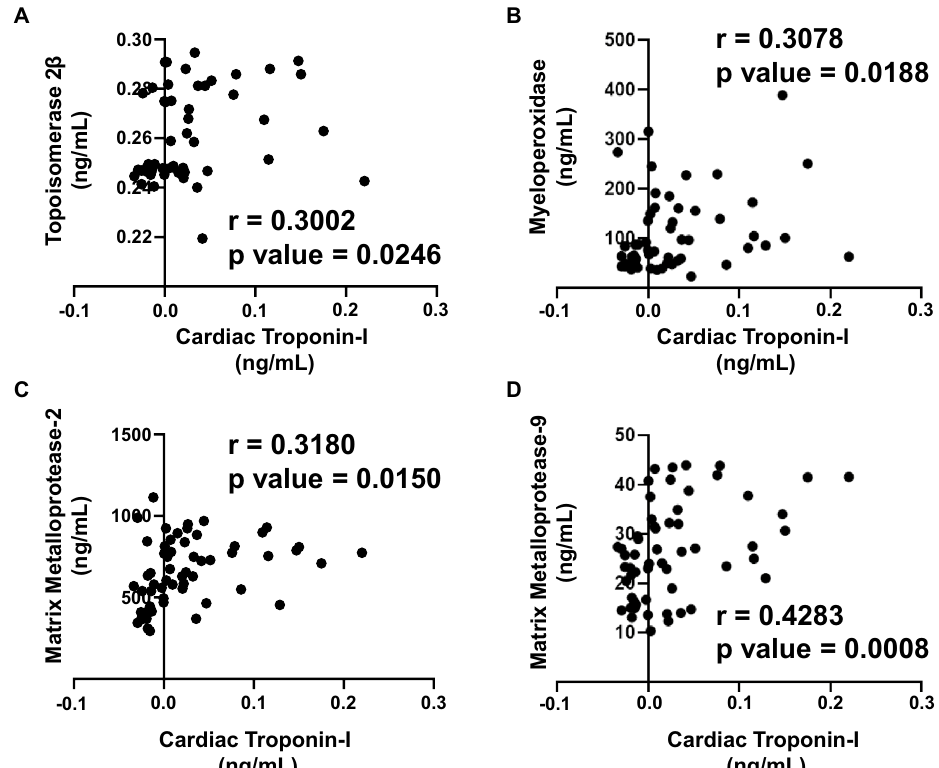
Figure 3. Correlation analysis of plasma biomarkers with high sensitive cardiac troponin I. Correlation was determined using Pearson’s r coefficient using two-tailed p -value to demonstrate significance (alpha = 0.05). Scatter dot plot between cardiac troponin I and plasma biomarkers showing statistical significance, which includes ( A ) Topoisomerase 2β, ( B ) MPO, ( C ) MMP2 and ( D ) MMP9. Each plot independently shows corresponding correlation coefficient ( r value) and significance ( p